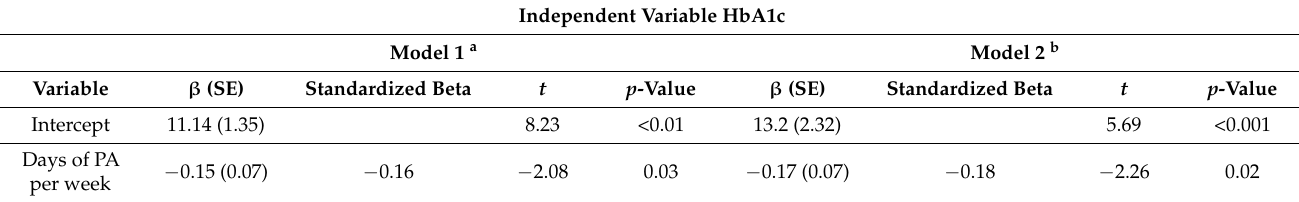
Table 2. Adjusted associations of sociodemographic, anthropometric, and physical activity with glycated hemoglobin ( n =